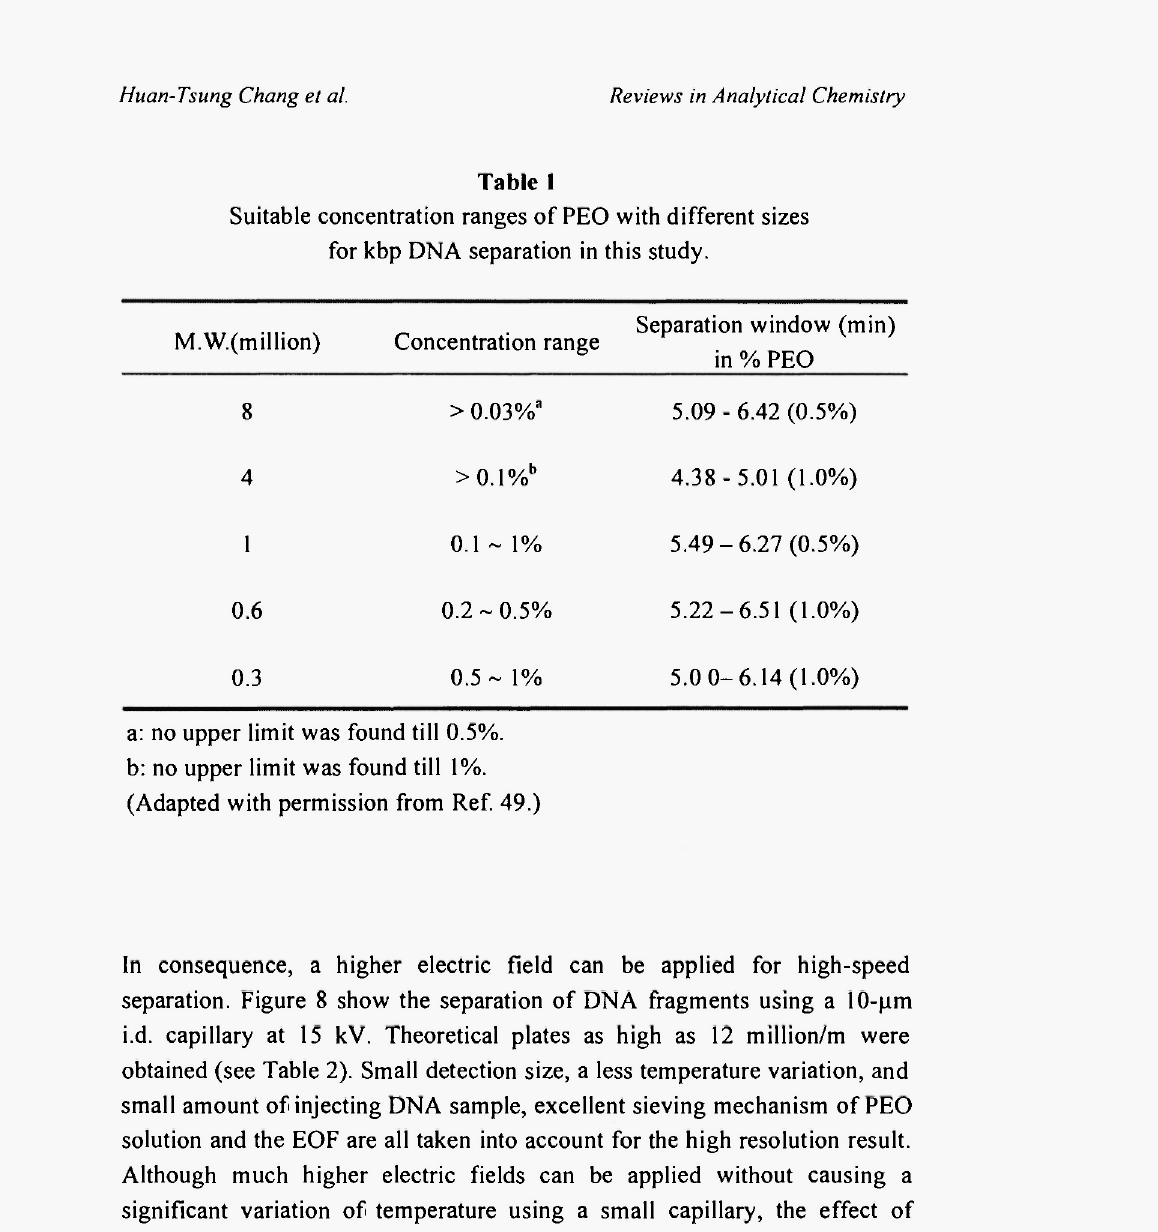
Suitable concentration ranges of PEO with different sizes for kbp DNA separation in this